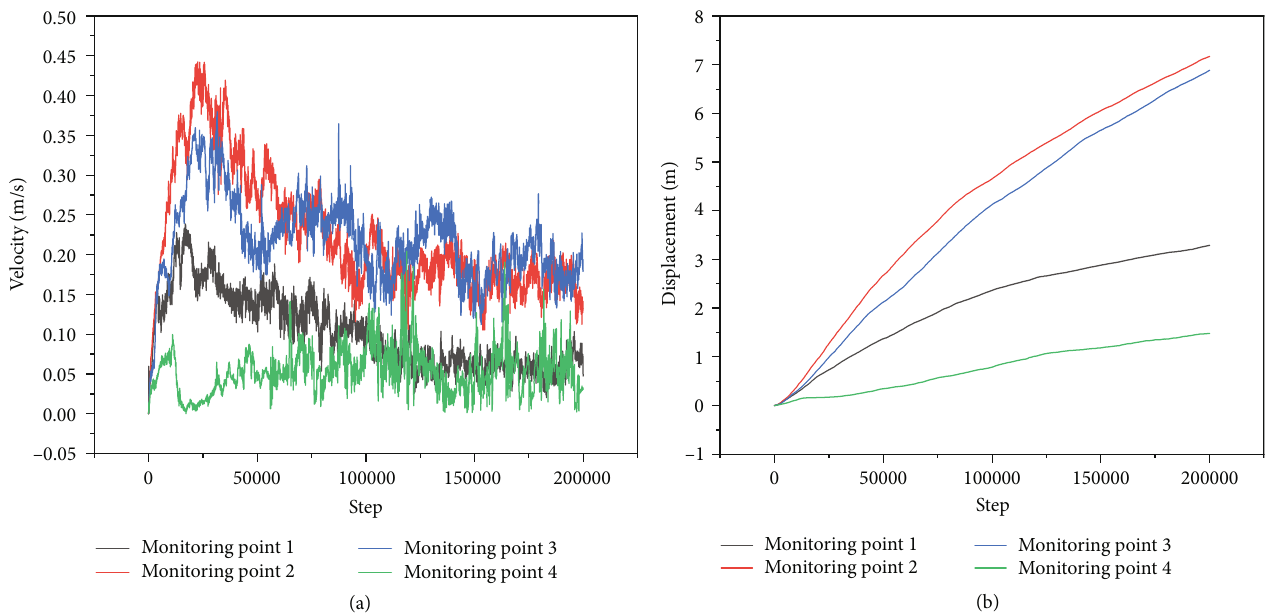
Figure 8: The dynamic characteristics of monitoring points during the collapse